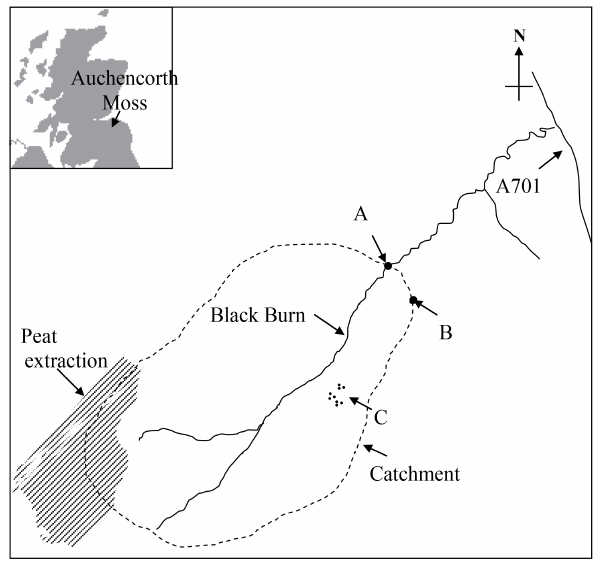
Figure 1. Schematic map of catchment and sampling sites at Auchencorth Moss. A points to the study catchment outlet and stream sampling site, B: monitoring station (wet-only analyser) and C: dip wells. Adapted from Dinsmore et al.